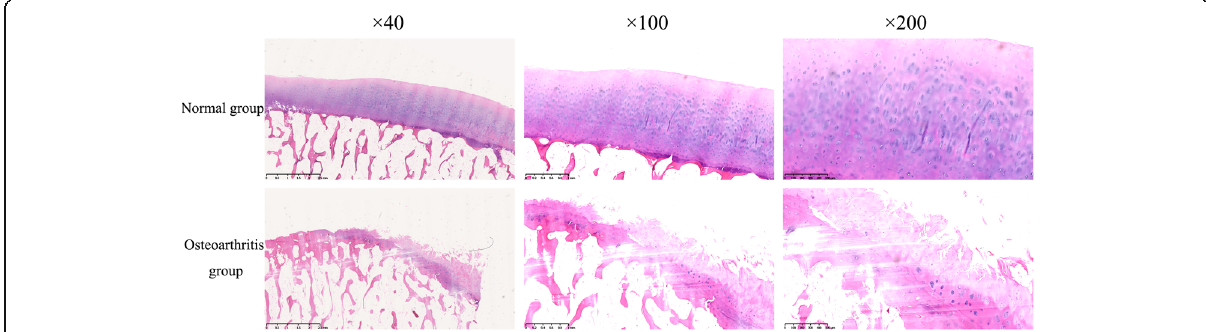
Fig. 1 The HE staining of the cartilage in the normal group and the osteoarthritis group